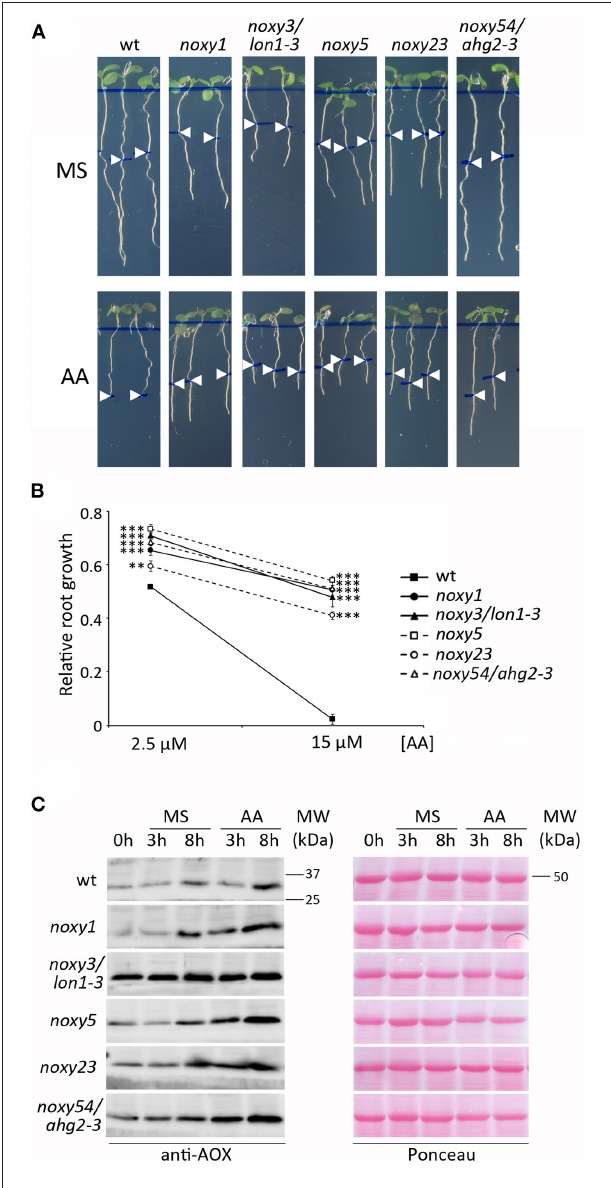
FIGURE 3 | Response of wild type, noxy1 , noxy3/lon1-3 , noxy5 , noxy23 , and noxy54/ahg2-3 plants to Antimycin A (AA). (A) Root phenotypes of seedlings grown for 3 days on MS medium and then transferred to MS with or without 15 µ M AA. Arrow heads indicate root length at the moment of transfer. (B) Relative root growth of seedlings in 2.5 and 15 µ M AA, defined as the fraction of growth on MS. Asterisks indicate significant differences with wild type plants in each condition ( n ≥ 8, Student’s t -test, *** P < 0.001, ** P < 0.01. (C) Western blot showing AOX accumulation in seedlings treated with 20 µ M AA. Proteins were extracted and examined at the indicated times. Left: immunoblots with anti-AOX antibody; right: Red Ponceau staining used as loading control. MW, Molecular